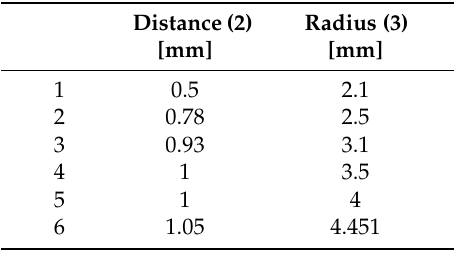
Table 4. Changes in distance (2) and radius (3) when distance (1) is fixed at 0.5 mm.